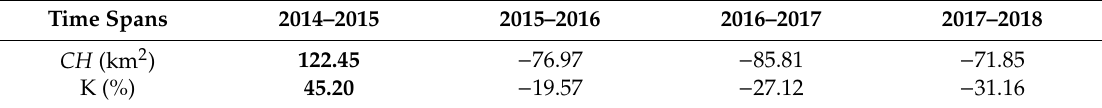
Table 4. The total area changes of SGLs from 2014 to 2018.